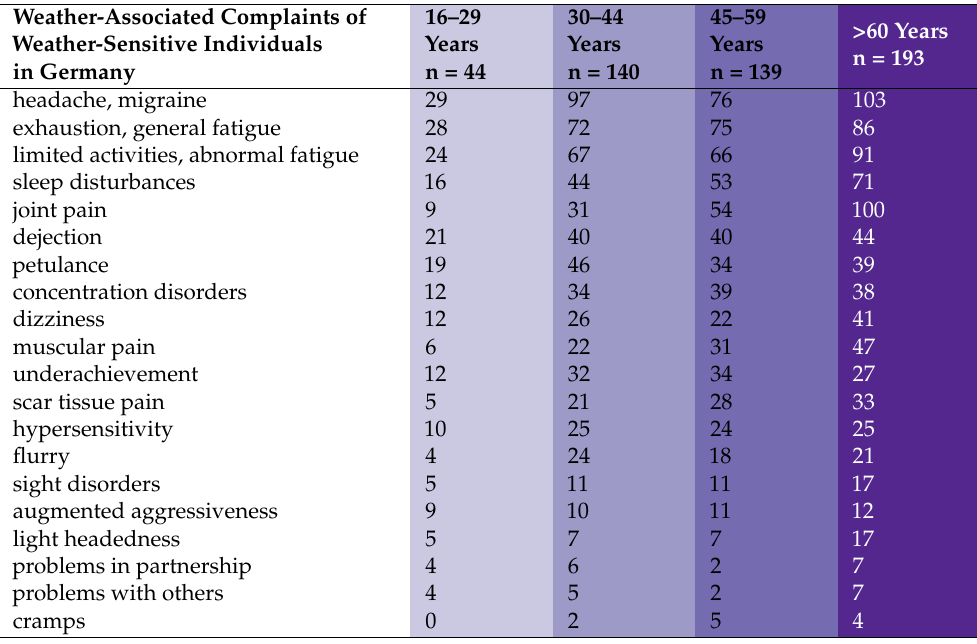
Table 2. Absolute number of reports of weather-associated complaints and symptoms per age group (color is chosen according to Figure 3) that occur among weather-sensitive individuals in Germany. Multiple responses were possible during the survey. Therefore, it is possible that the same respondent reported different weather-associated complaints and thus contributed to the absolute number of more than one weather-associated complaint. The data are based on representative surveys conducted by IfD Allensbach in January 2021 (self-assessment by